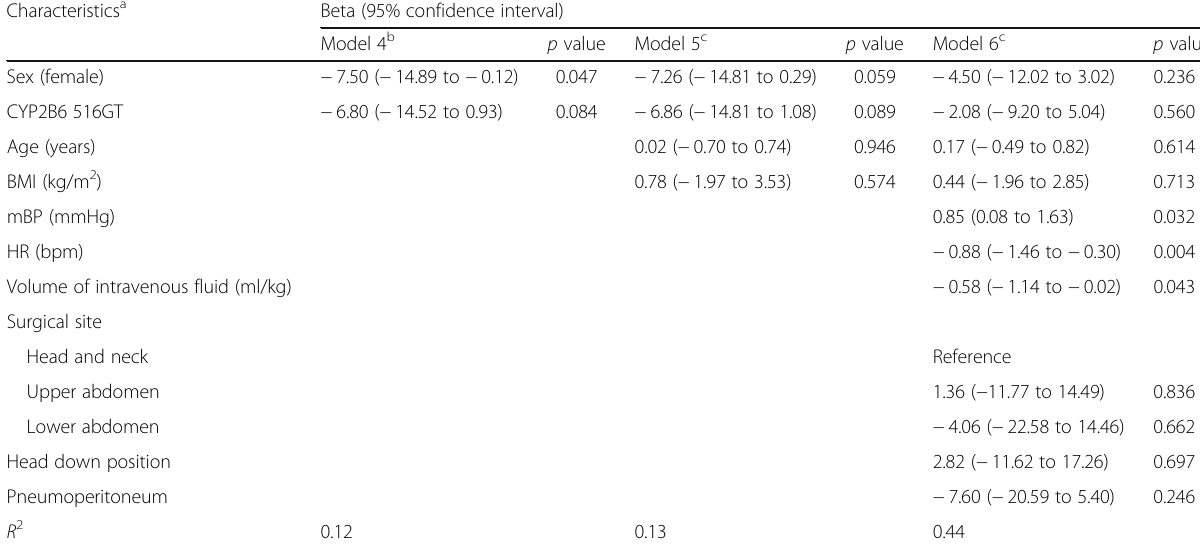
Table 4 Regression coefficients estimated with linear regression, mutually adjusted for sex and CYP2B6 516G > T polymorphisms Characteristics